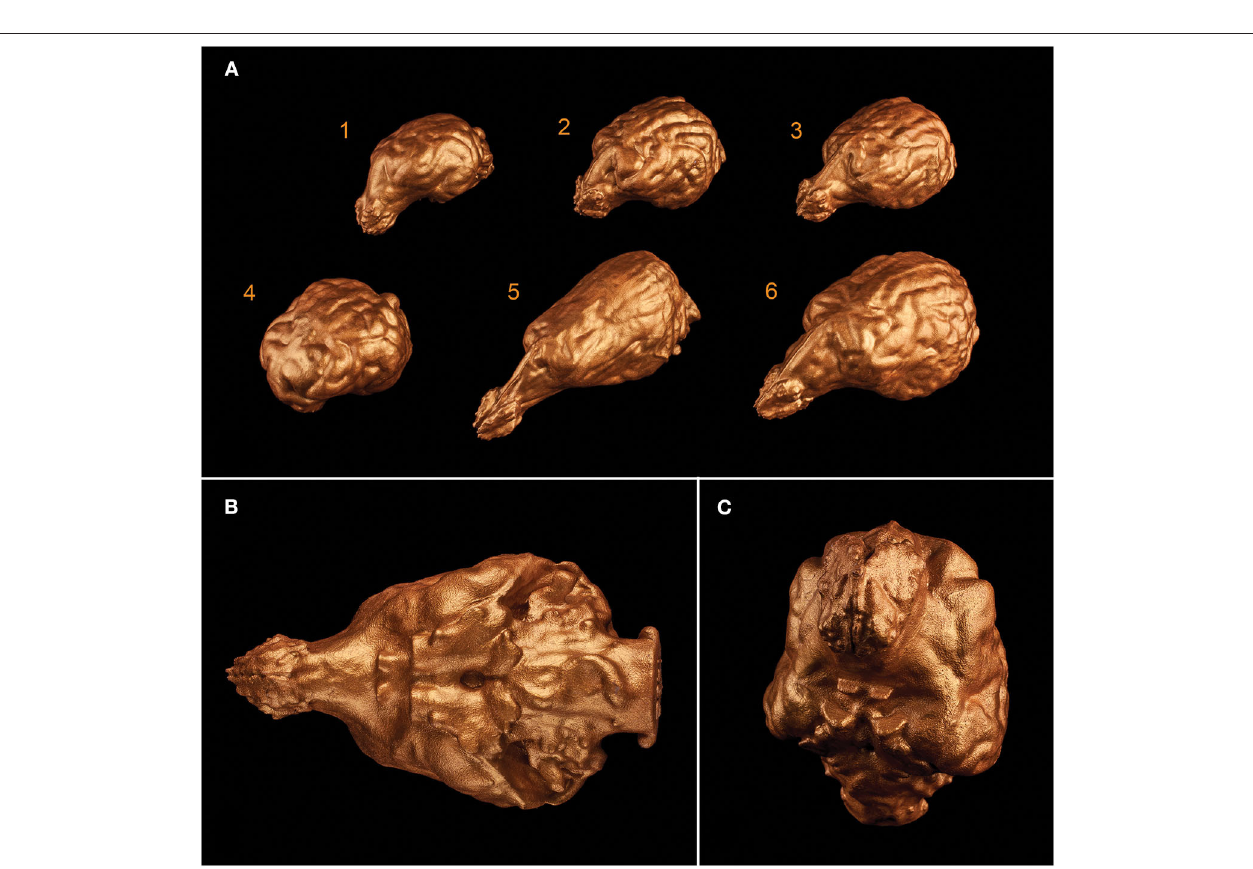
FIGURE 12 | 3D prints of different endocasts. (A) Endocast of a Welsh terrier (1), a border collie (2), a Weimaraner (3), a pug (4), a borzoi (5), and a gray wolf (6). (B) Ventral aspect of the endocast of a Weimaraner. (C) Rostroventral aspect of the endocast of a border collie.